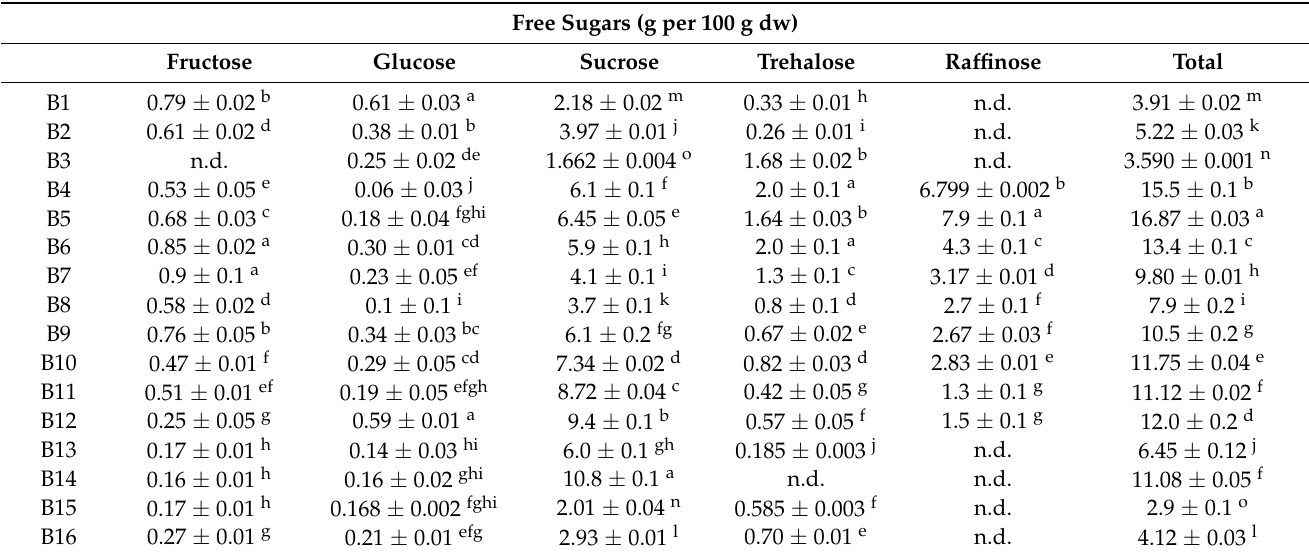
Table 3. Free sugars identified on Cynara cardunculus L. blades collected at different growth